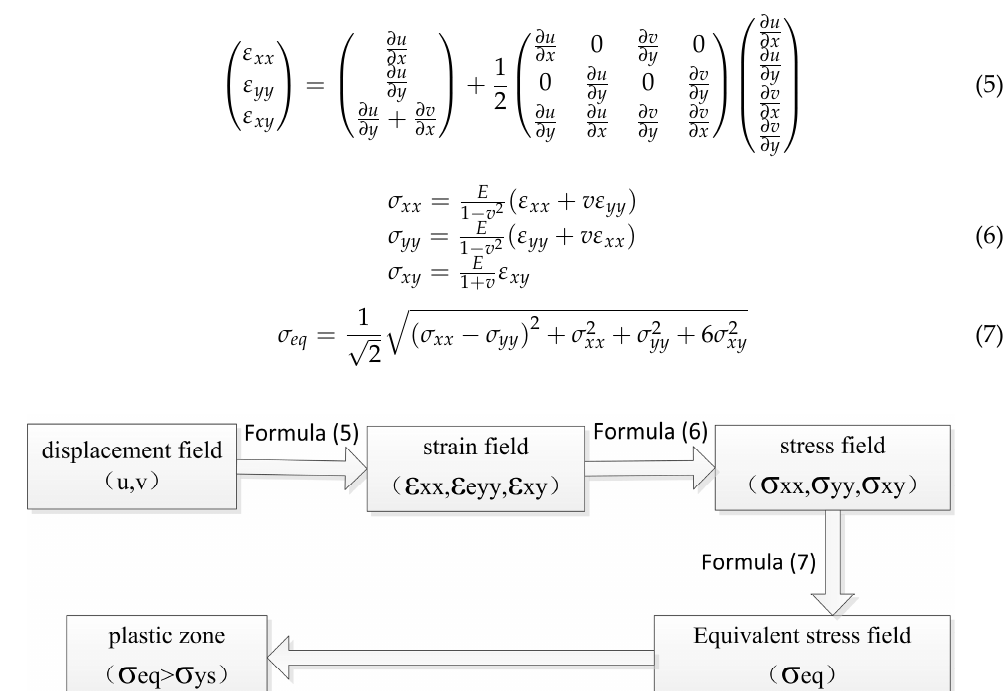
Figure 4. Variation in vertical displacement with x-coordinate on the crack line of specimens B1 and W1: ( a ) specimen B1 ( a = 25.02 mm); ( b ) specimen W1 ( a = 24.48 mm).